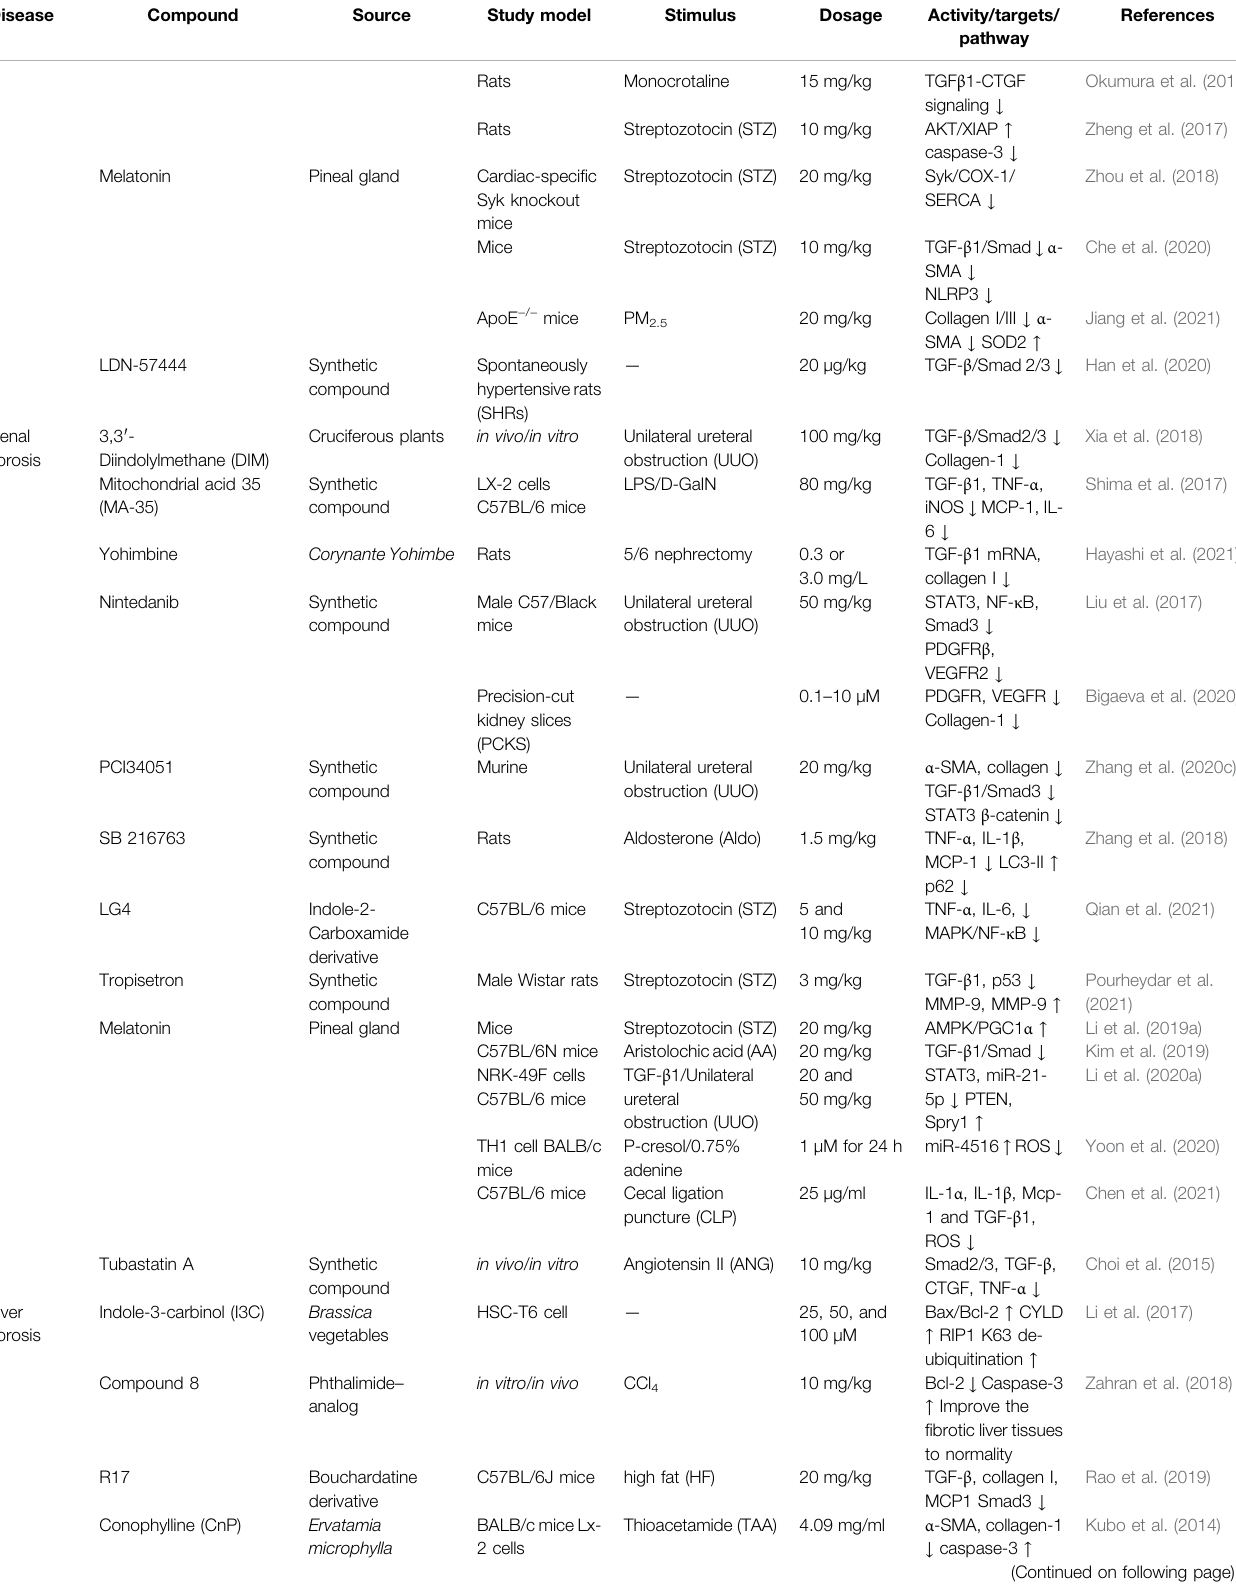
TABLE 1 | ( Continued ) Therapeutic activities of indole alkaloids and indole derivatives on organ fi